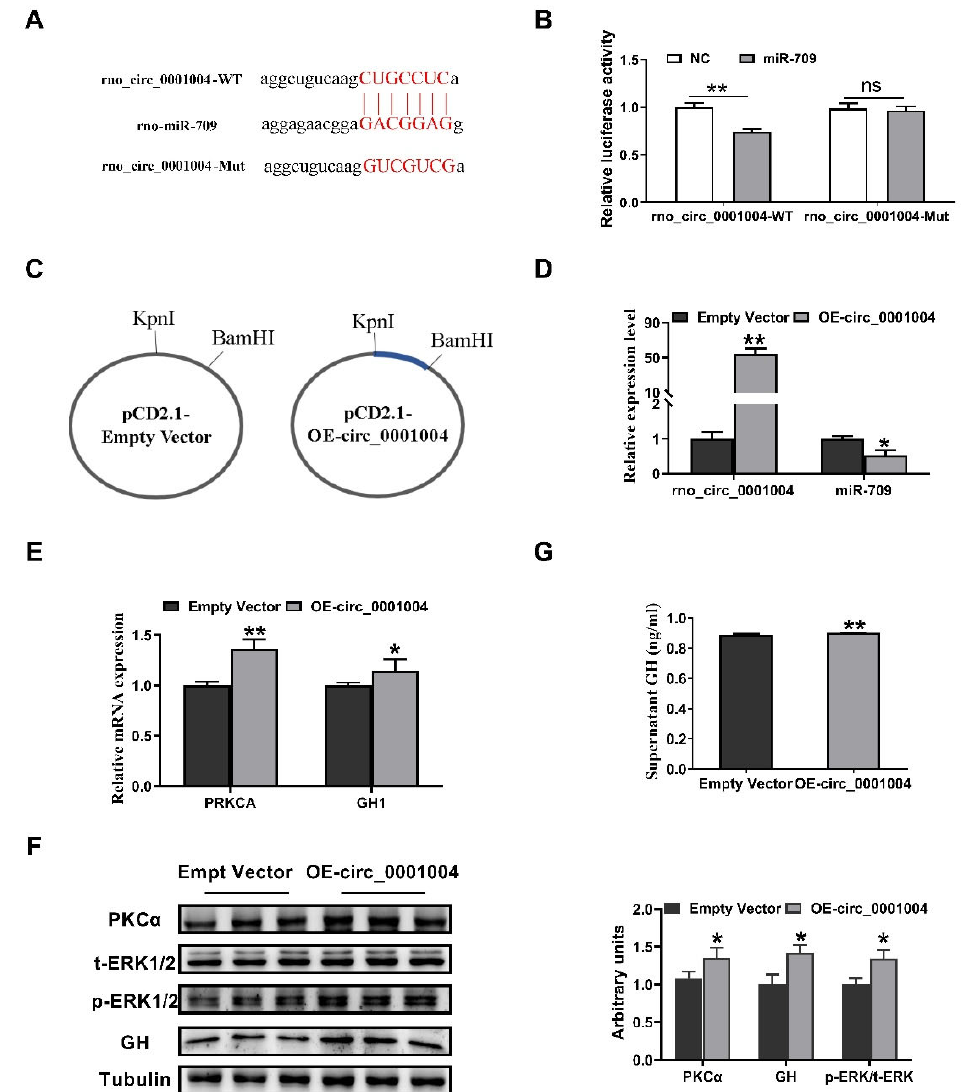
Figure 2. Rno_circ_0001004 antagonizes miR-709-mediated repression the synthesis and secretion of GH. ( A ) Bioinformatics target prediction. ( B ) Dual luciferase reporter gene assay verified. ( C ) Construction of rno_circ_0001004 overexpression vector. ( D ) Expression of rno_circ_0001004 along with miR-709 in empty vector and overexpression vector in GH 3 by qRT-PCR. ( E ) mRNA level of PKCA and GH1 after transfection of OE-circ_0001004. ( F ) Western blot evaluation results of PKC α , t-ERK1/2, p -ERK1/2 and GH protein expression following transfection with rno_circ_0001004 in GH 3 cells. ( G ) changes in supernatant GH level: average expression rose from 0.87 to 0.9 ng/mL. (* p < 0.05; ** p < 0.01.)